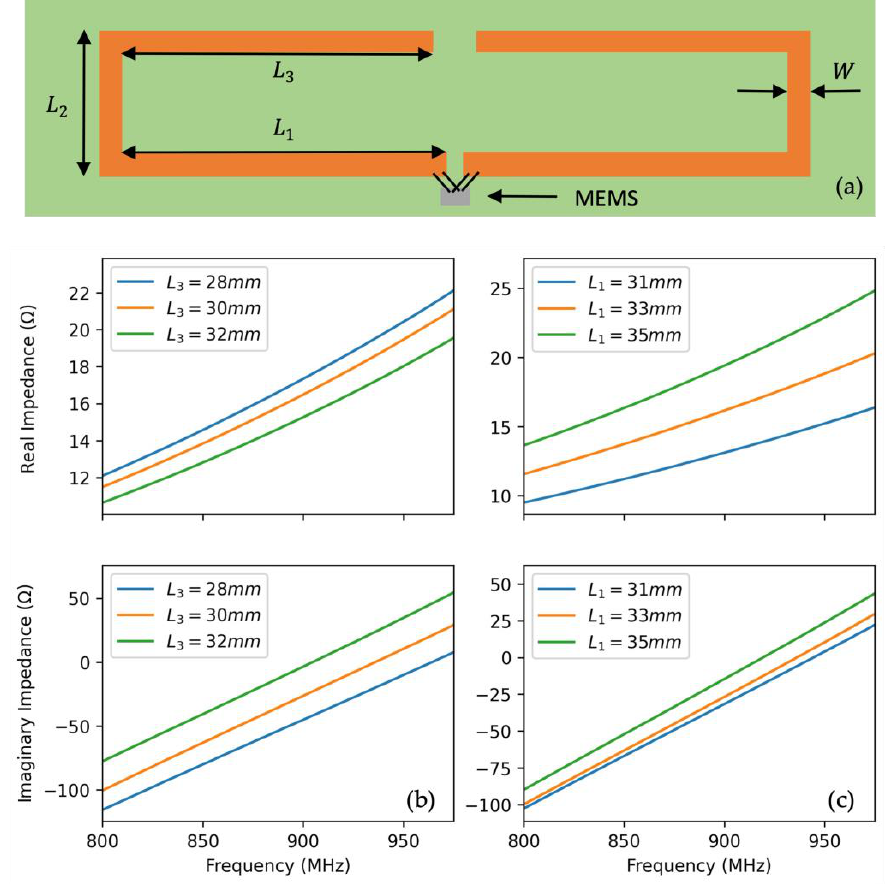
Figure 5. ( a ) Schematic of the sensor with the critical design dimensions of the RFID antenna highlighted. ( b ) Simulated antenna impedance for 𝐿 3 sweep and W = 3mm, 𝐿 1 = 33mm, and 𝐿 2 = 33mm. ( c ) Simulated antenna impedance for 𝐿 1 sweep and W = 3mm, 𝐿 2 = 33mm, and 𝐿 3 = 30mm.